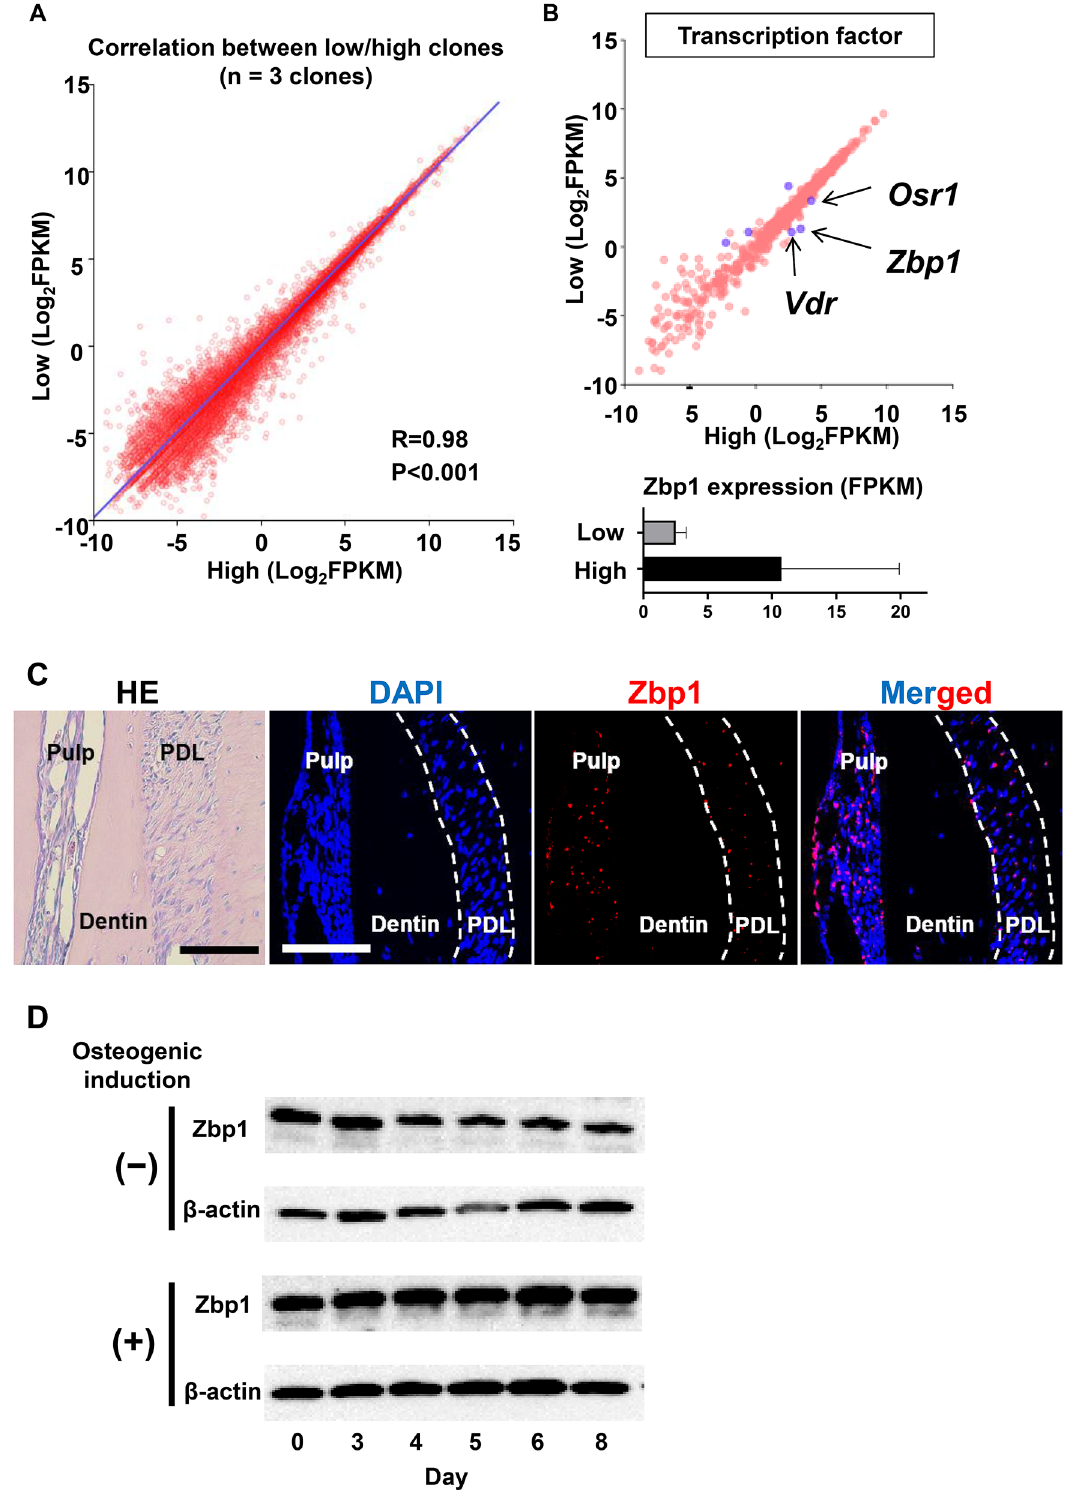
Figure 3. RNA-seq analysis of progenitor clones with high and low osteogenic potential. ( A ) Scatter plots of the mean values of three clones of each type calculated by RNA-seq analysis are shown. FPKM: fragments per kilobase of exon per million reads mapped. ( B ) Among the genes in A, genes encoding transcriptional regulators are shown. The differentially expressed genes (DEGs, showing > twofold statistically significant differences) are shown in purple. The Zbp1 expression (FPKM) is shown in a bar chart. ( C ) Representative images of hematoxylin and eosin staining and RNAscope in situ hybridization of adult periodontal ligament (PDL) are shown. Zbp1 signals are shown in red. Neighboring slides were used. The PDL is shown as a white dotted line. Scale bar: 100 μm. ( D ) High clones were seeded into plates in the absence of FGF-2 and cultured with osteogenic medium on the next day. Whole cell lysate were collected at days 0, 3, 4, 5, 6, and 8 of osteogenic induction, respectively, and the representative Western blotting results for Zbp1 and β-actin are shown. The original image and quantification data are included in Supplementary Figure